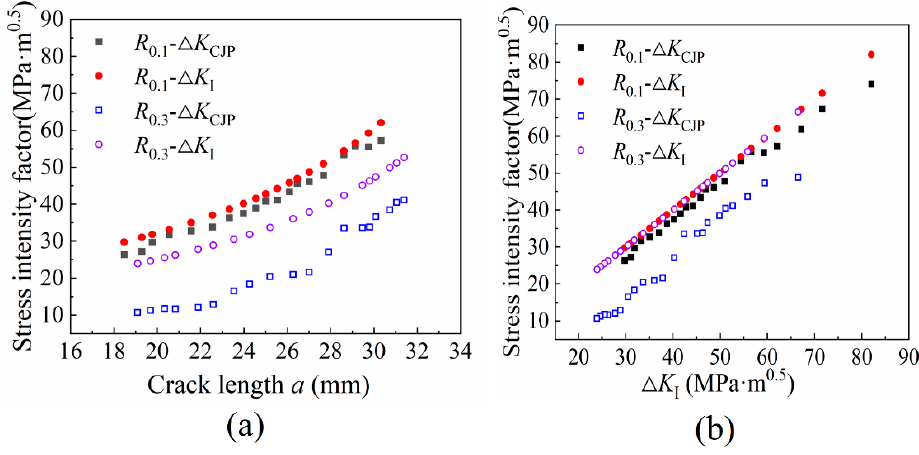
Figure 13. The variation trend of SIF ( a ) Variation trend of a - ∆ K CJP ( b ) Variation trend of ∆ K I - ∆ K CJP.